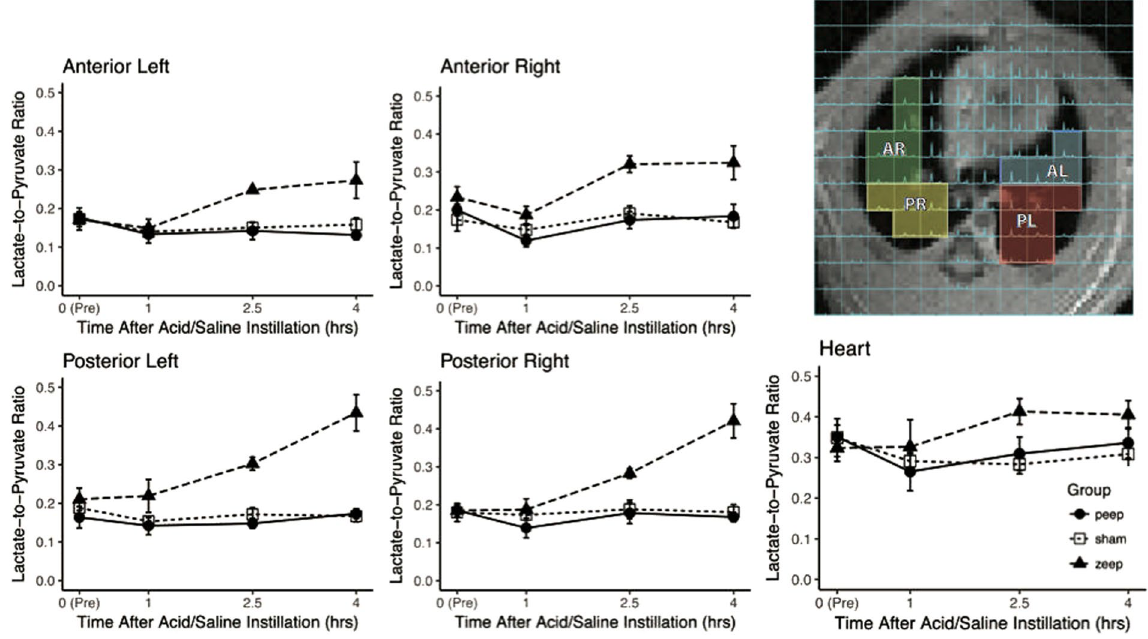
Figure 7. The right panel shows a selection of the voxels in the hyperpolarized carbon-13 spectroscopic image overlay. Lactate-to-pyruvate ratio was similar at baseline in all regions across all groups, and increases 2.5 hours after acid instillation in all lung regions in ZEEP rats. 4 hours after acid instillation, the ratio continues to increase in the posterior region on both sides. The lactate-to-pyruvate ratio measured in the myocardium and heart chambers remains unchanged over time in all groups (AL: anterior left, PL: posterior left, AR: anterior right and PR: posterior